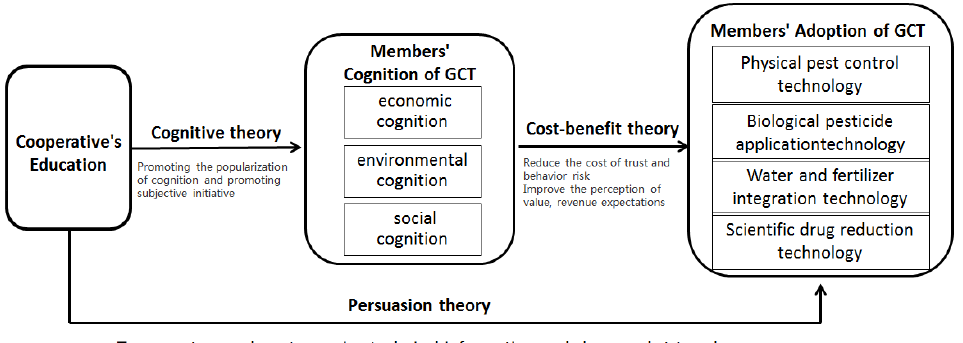
Figure 1. Theoretical model of GCT adopted by